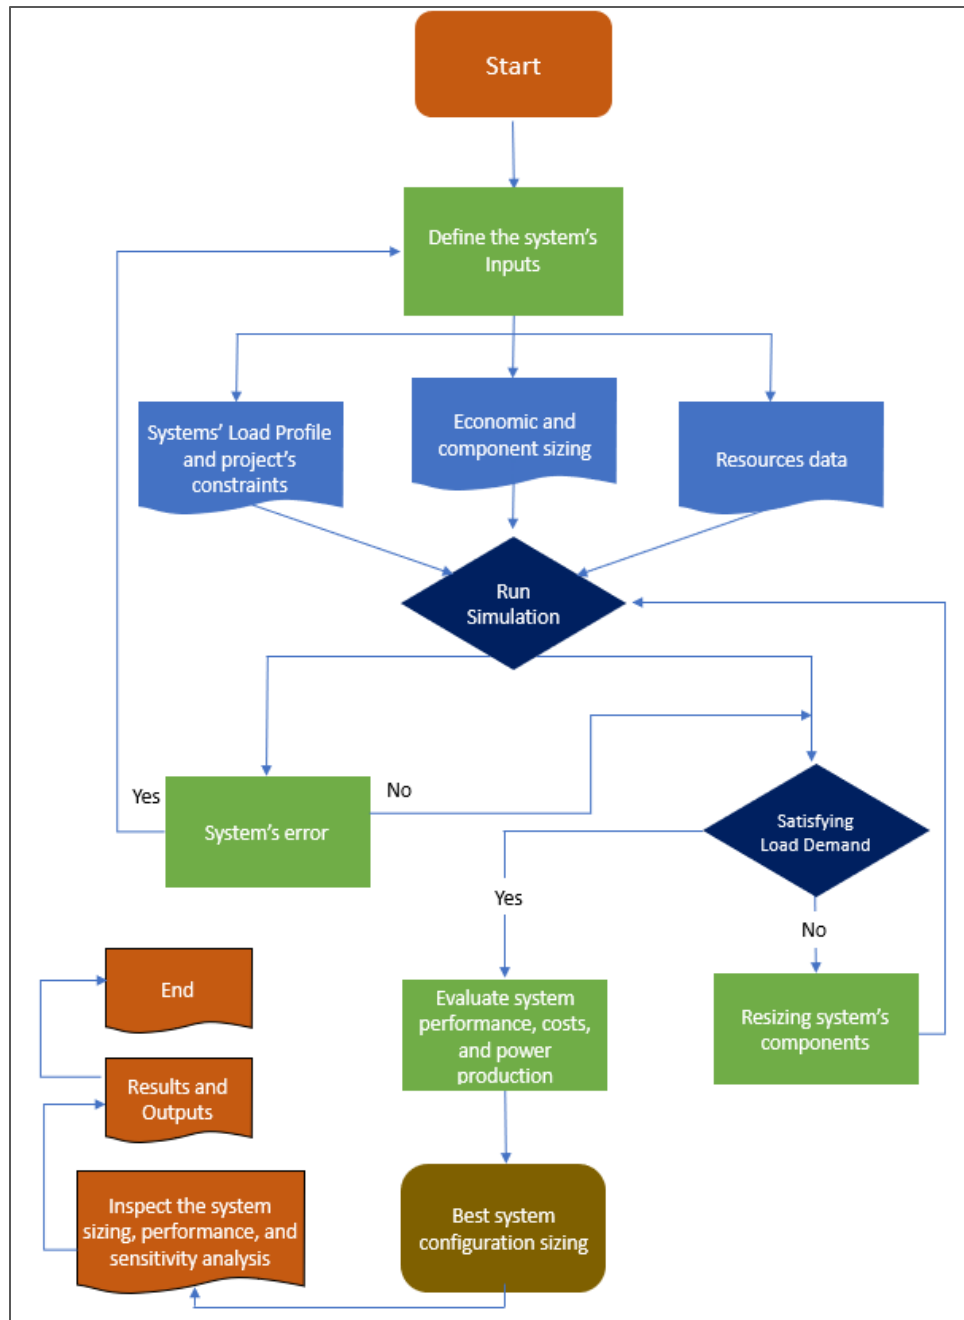
Figure 3. Workflow Process Chart.